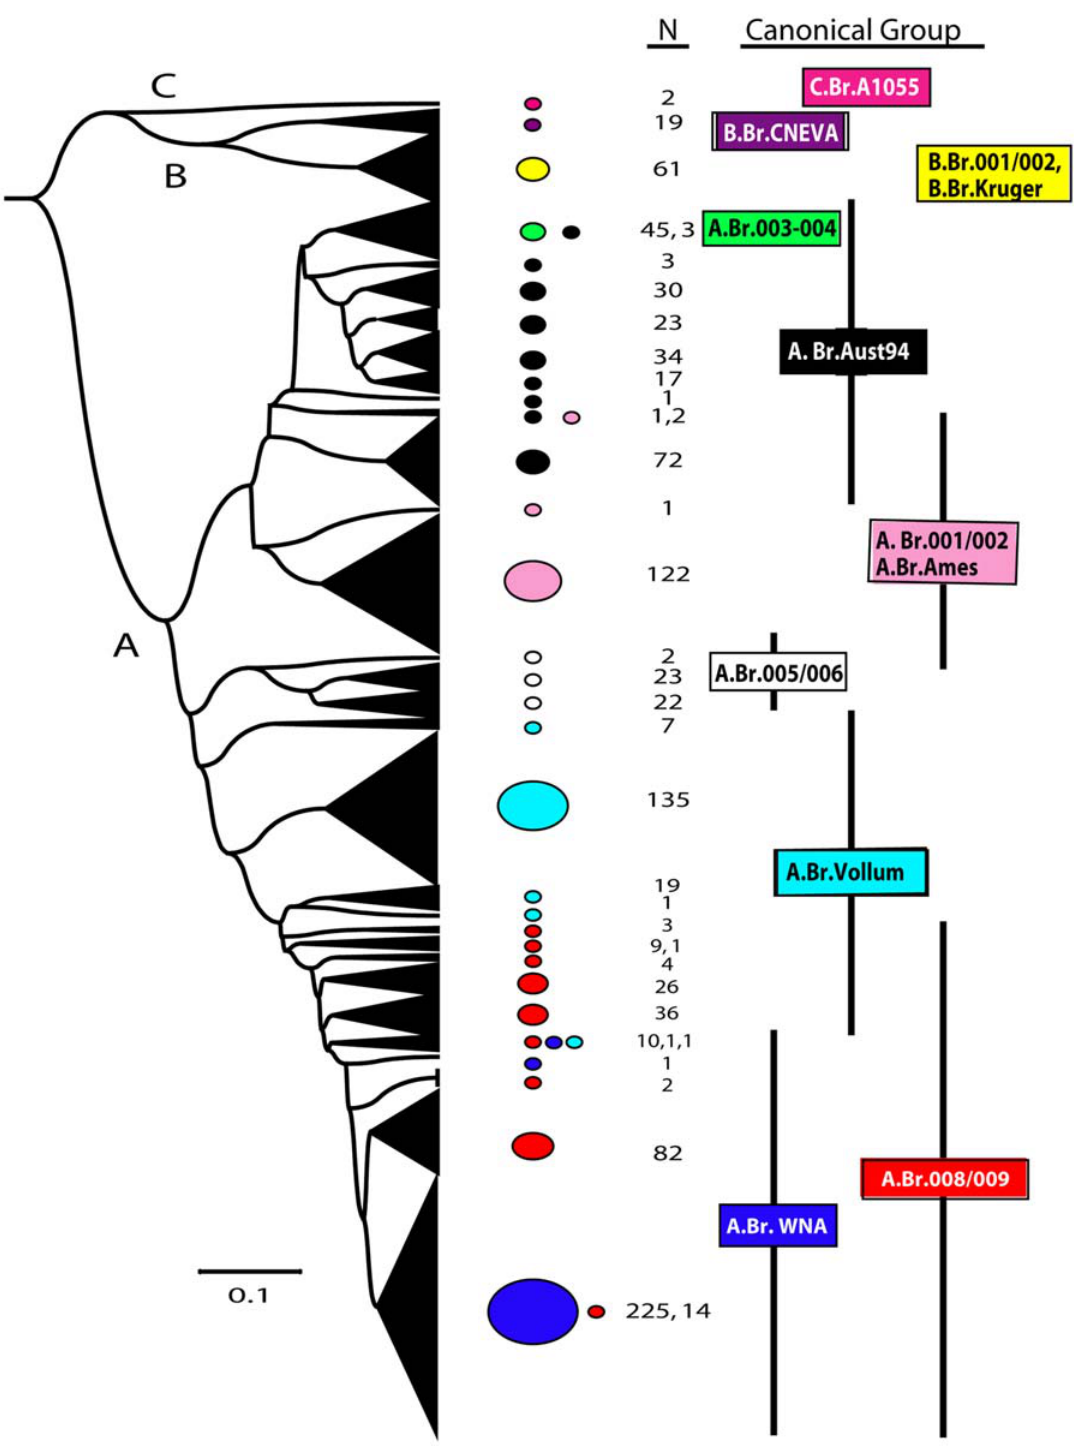
Figure 2. UPGMA dendrogram of VNTR data from worldwide B. anthracis isolates: Fifteen VNTR loci and UPGMA cluster analysis were used to establish genetic relationships among the 1,033 B. anthracis isolates. In this UPGMA dendrogram, which was created using MEGA software [39], groups of genetically similar isolates are collapsed into black triangles that are sized in proportion to the number of isolates in that particular lineage. VNTR loci mutate at faster rates than SNPs and, hence, provide greater resolution for terminal branches. Longer branches, such as the B and C lineages, have length underestimation in this analysis due to mutational saturation. The scale bar indicates genetic distance. Also illustrated on this figure is the distribution of the canonical SNP groups relative to the MLVA phylogeny (right columns). The number of isolates (N) associated with each canSNP group is shown in the second column. The correlation between the phylogenetic clusters identified by the canSNP and MLVA analysis with regards to the world wide geographic distribution of these clusters can be seen in Figure 3.